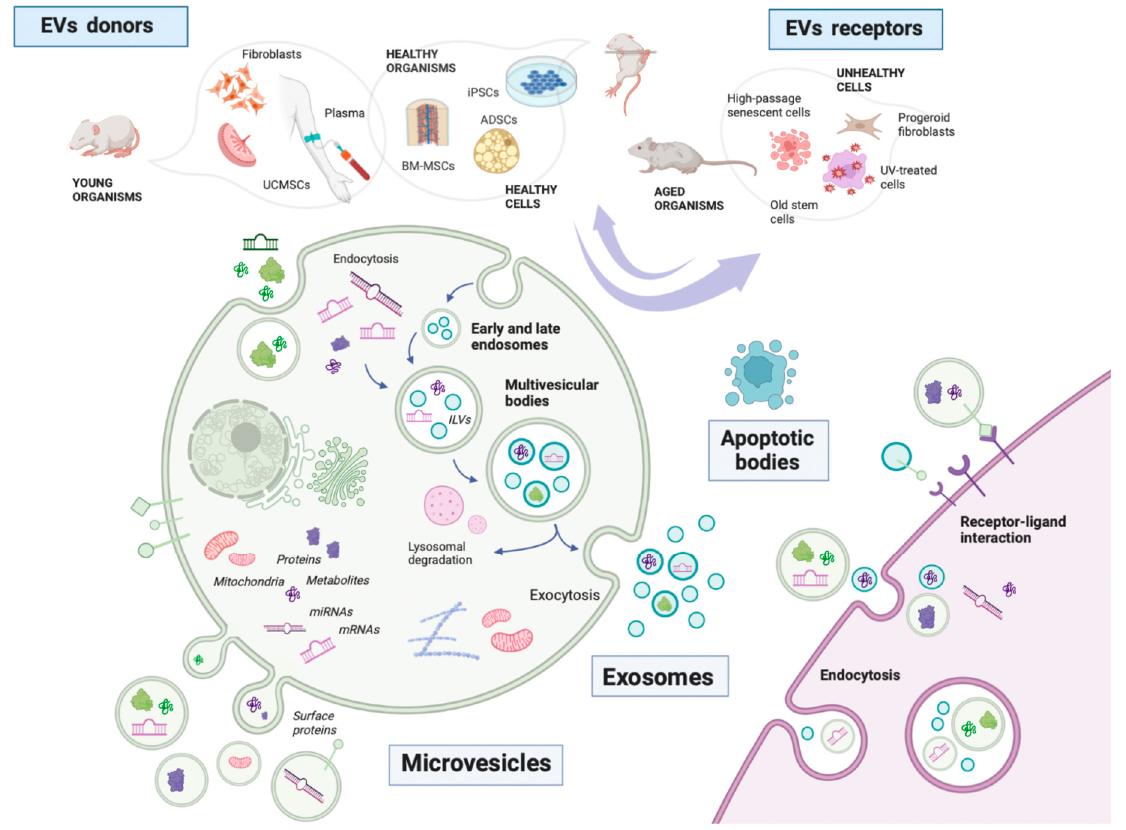
Figure 1. EVs’ origins, receptors, biogenesis, and cargo in aging research. ILVs: intraluminal vesicles; UCMSCs: umbilical cord mesenchymal stem cells; BM-MSCs: bone marrow mesenchymal stem cells; iPSCs: induced pluripotent stem cells; and ADSCs: adipose-derived stem cells. Created with BioRender.com; accessed 12 December 2022.